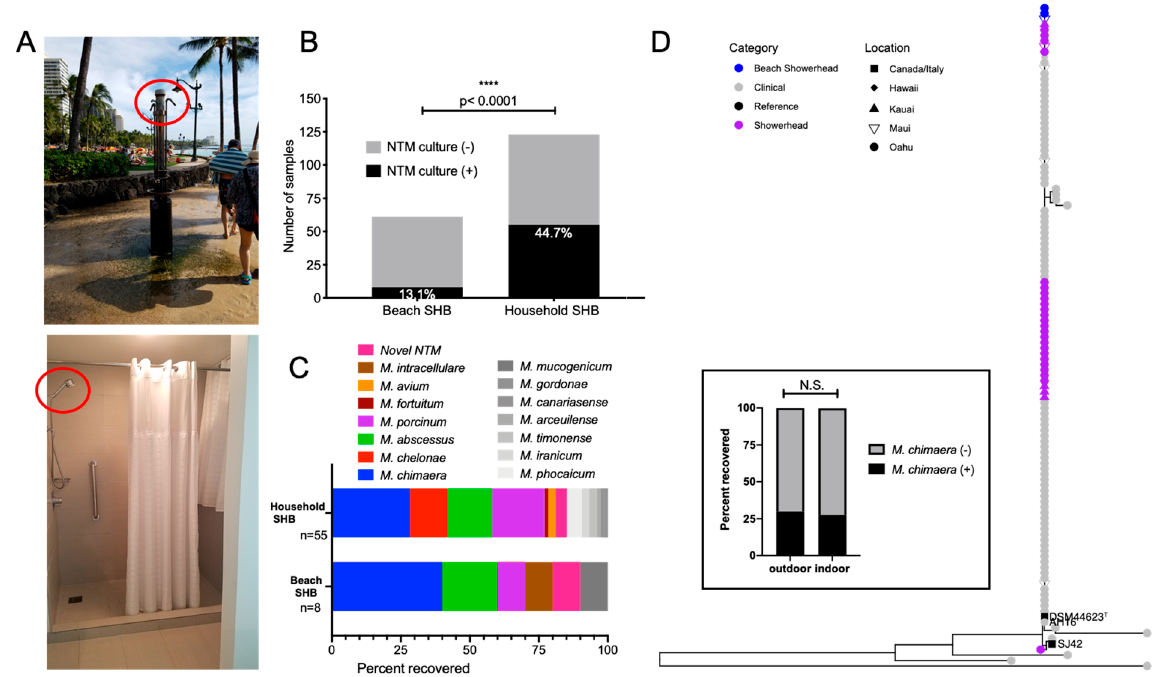
Figure 5. NTM diversity among outdoor beach showerhead biofilms (SHB) compared to indoor household SHB. ( A ) Examples of outdoor beach and indoor household showerheads (red circles, respectively) that were sampled in this study. ( B ) Beach SHB (n = 8/61) were less likely to be NTM culture positive than indoor SHB (n = 55/123). ( C ) Breakdown of the NTM species identified between outdoor beach SHB compared to indoor household SHB. ( D ) Inset box: No significant difference between M. chimaera recovery from either SHB type. N.S.= not significant. Phylogenetic analyses of respiratory and environmental SHB M. chimaera isolates based on rpoB gene sequencing.